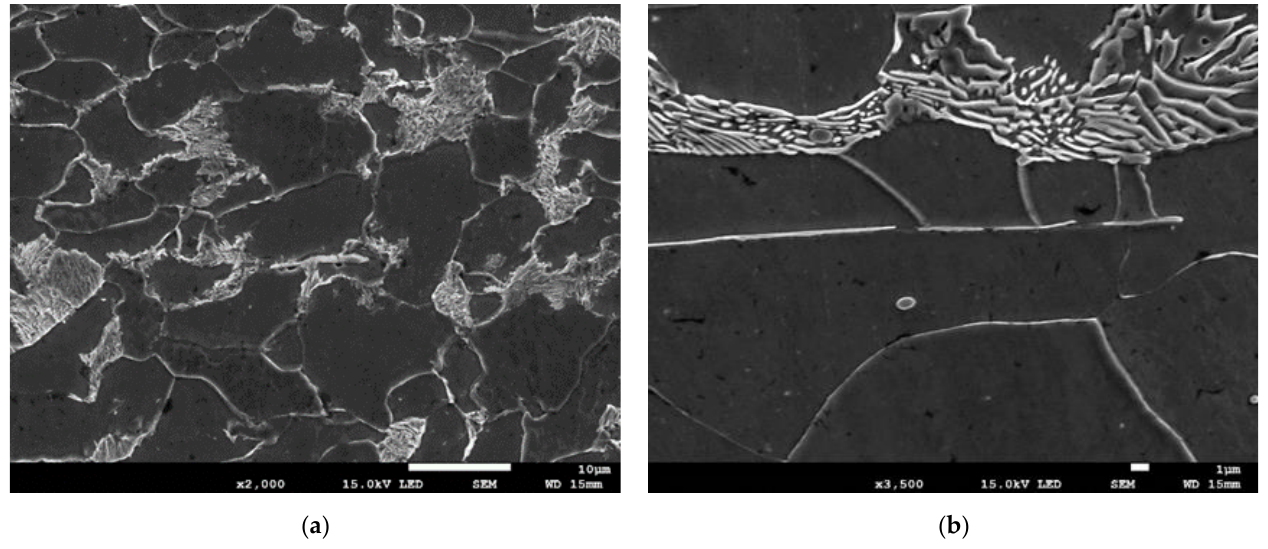
Figure 6. ( a,b ) Microstructure of S235 steel in the nondeformed condition. Figure 6. ( a , b ) Microstructure of S235 steel in the nondeformed